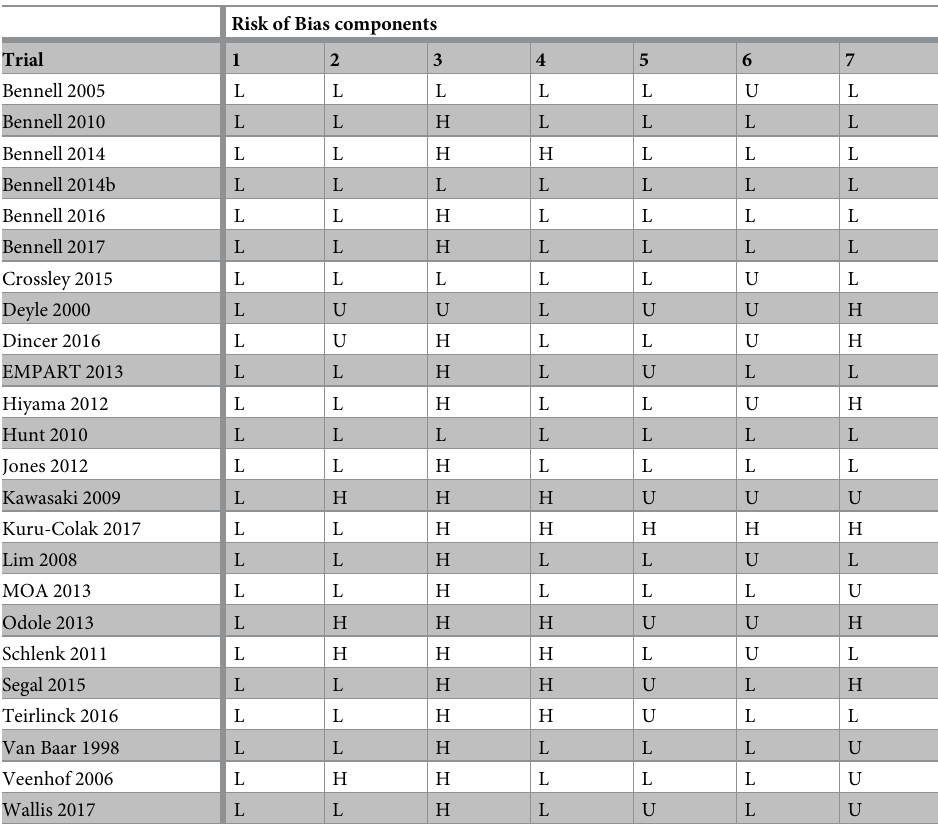
Table 2. Summary of risk of bias